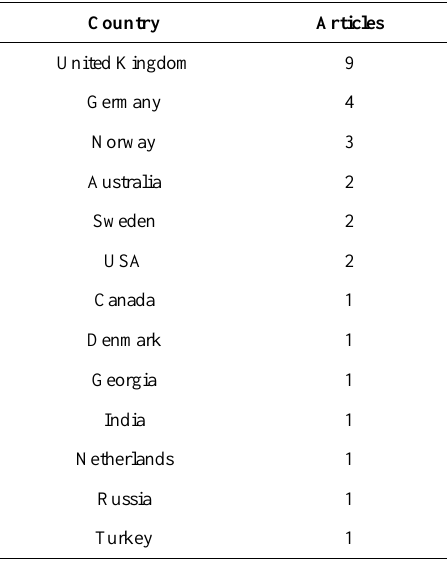
Table 6. Distribution by Country